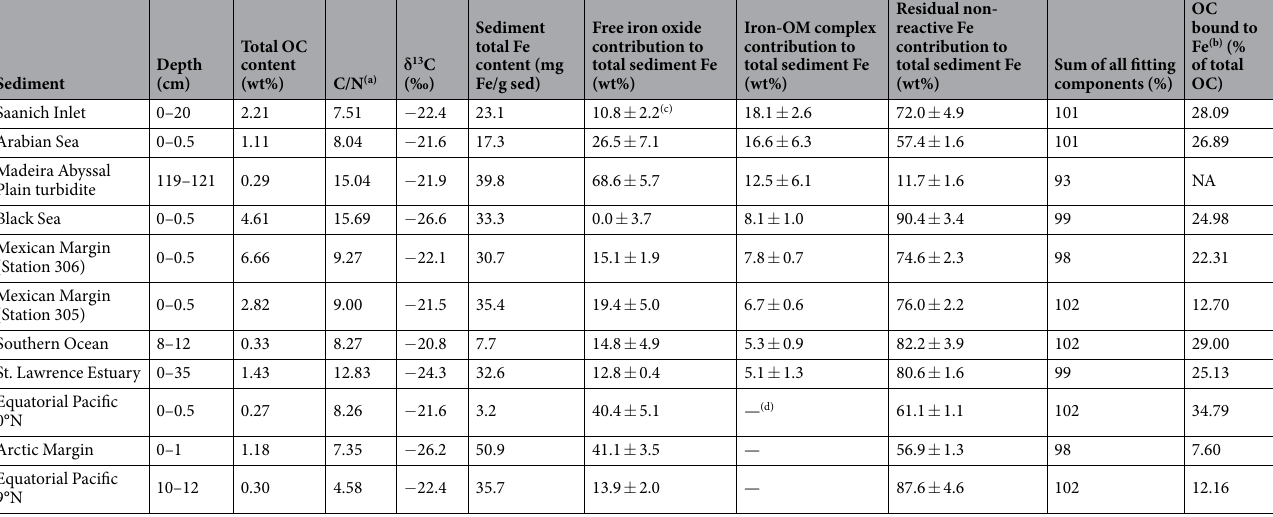
Table 1. Composition of the samples and raw sediment Fe K-edge Linear combination fitting results. (a) Atomic the fitting results. (d) Component not used in the combinatorial linear fitting